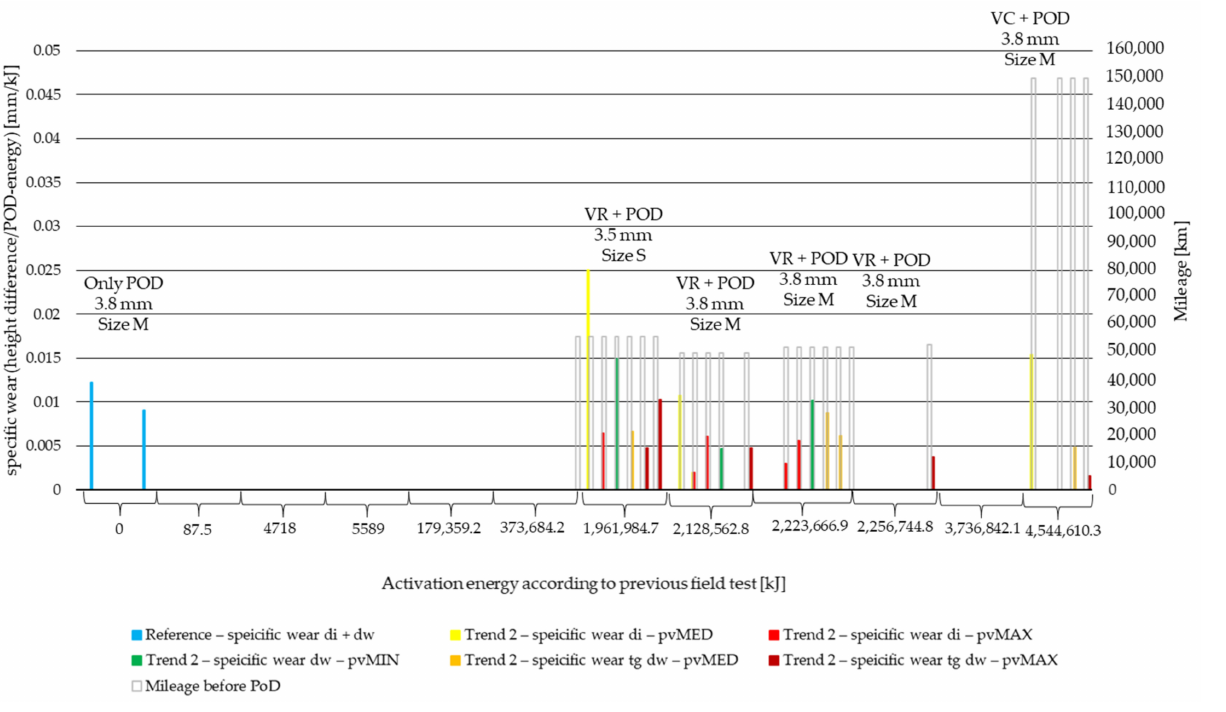
Figure 12. PoD specific wear values of cut material samples from inner and working diameter after minimum, medium and maximum pv level pin-on-disc tests with previous field-test (Table 2) mileage with mileage along Joule scale—Trend 2: moderate load cases: VR,